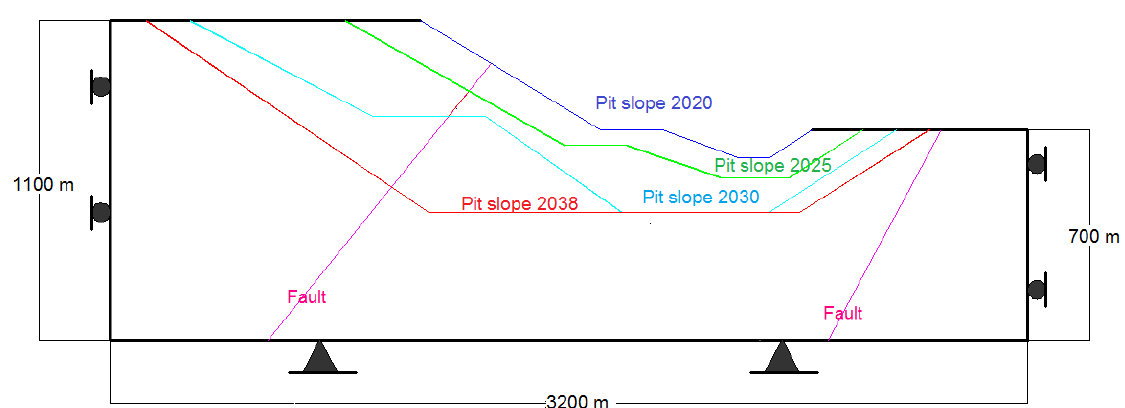
Figure 4: Simplified 2D model